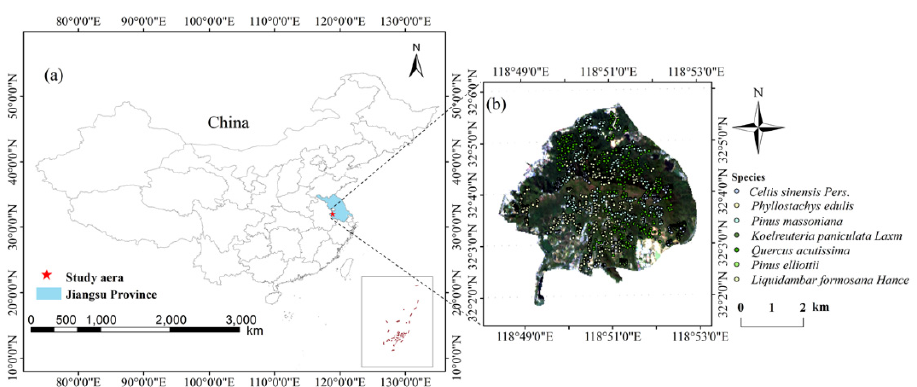
Figure 1. The geographical location of the study area. ( a ) Purple Mountain, Jiangsu Province, China. ( b ) GF-5 image (the Purple